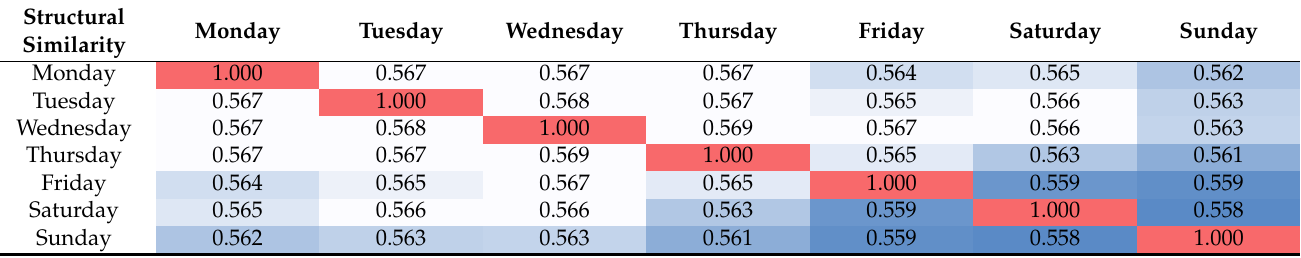
Table 5. Structural similarity of the OD matrixes in New